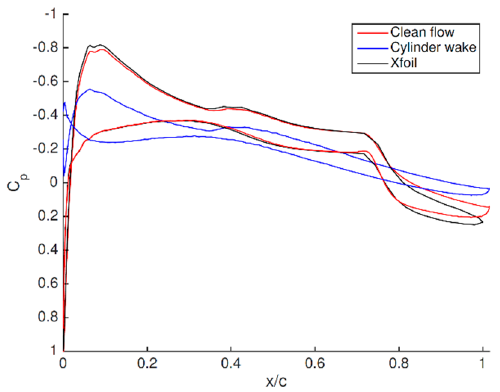
Figure 22. Mean pressure distribution on airfoil surface.